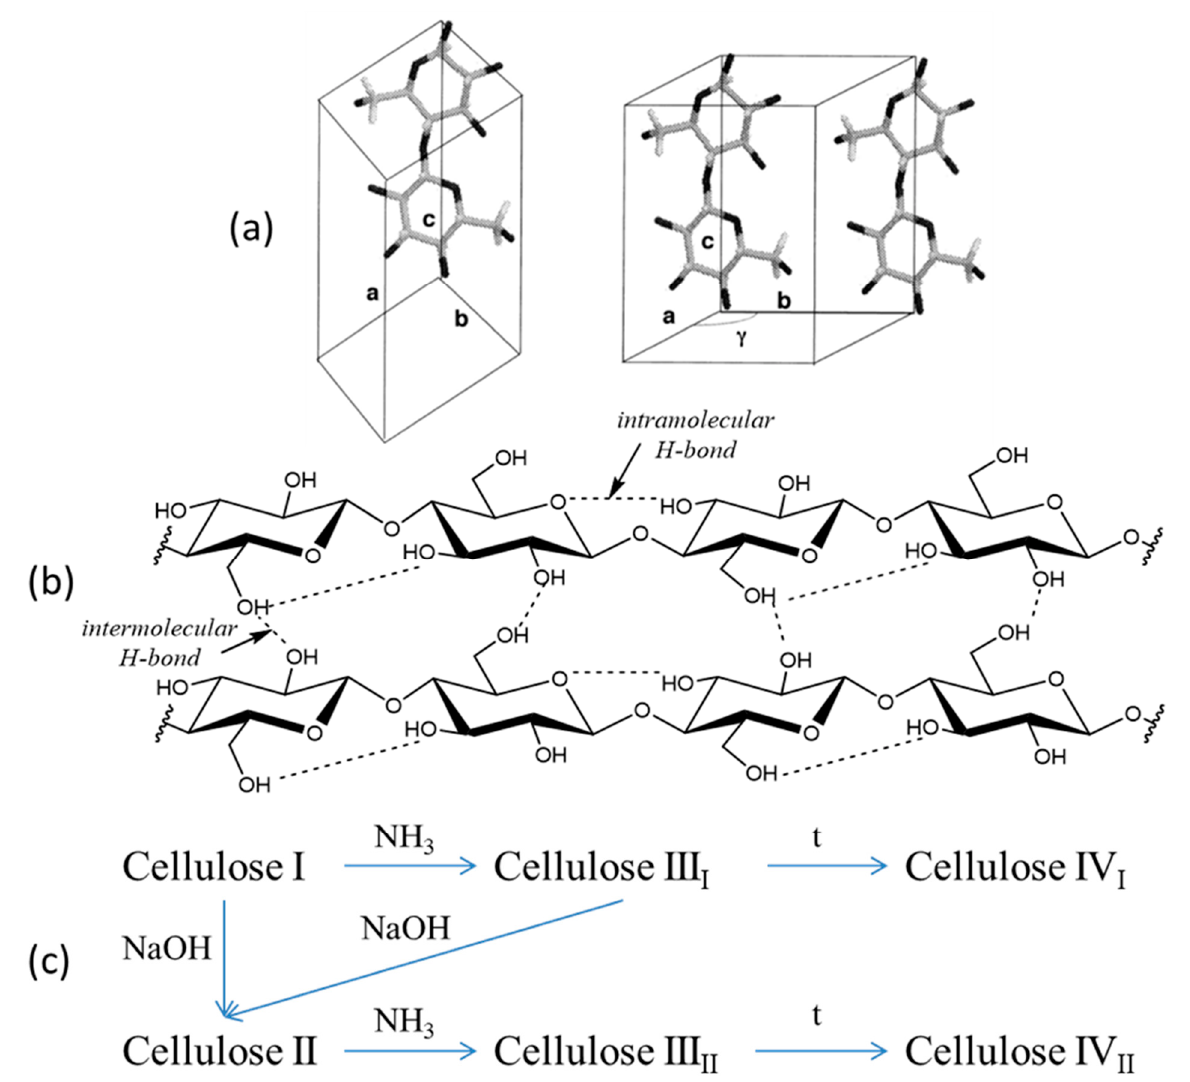
Figure 2. Complex molecular structure of cellulose: ( a ) native cellulose I unit cells, triclinic I α and monoclinic I β [37] © 2022 National Academy of Sciences; ( b ) H-bond network of cellulose I; ( c ) polymorph transitions.